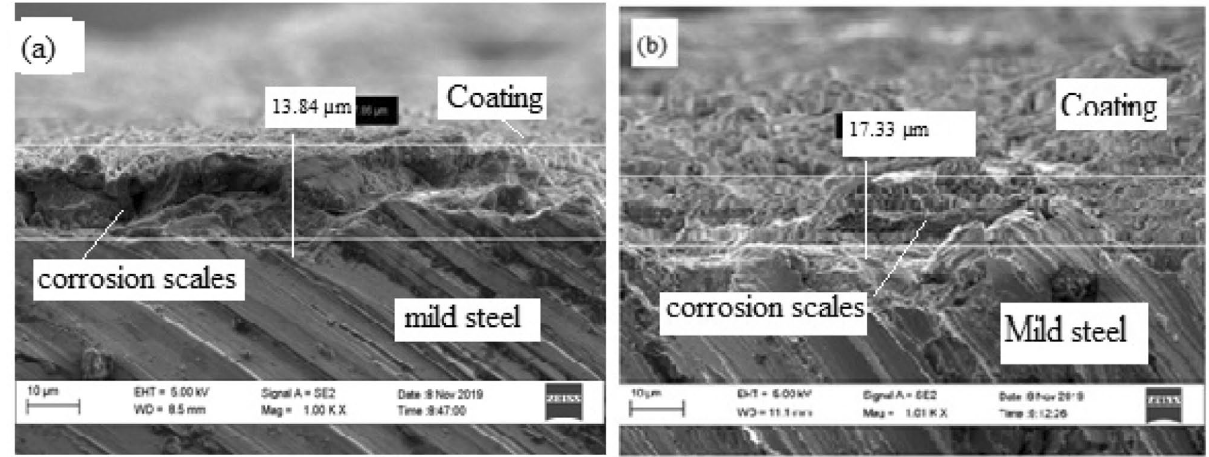
Figure 12. SEM cross-sectional view of the sample coated and heated at 100 °C ( a ) before corrosion and ( b ) after